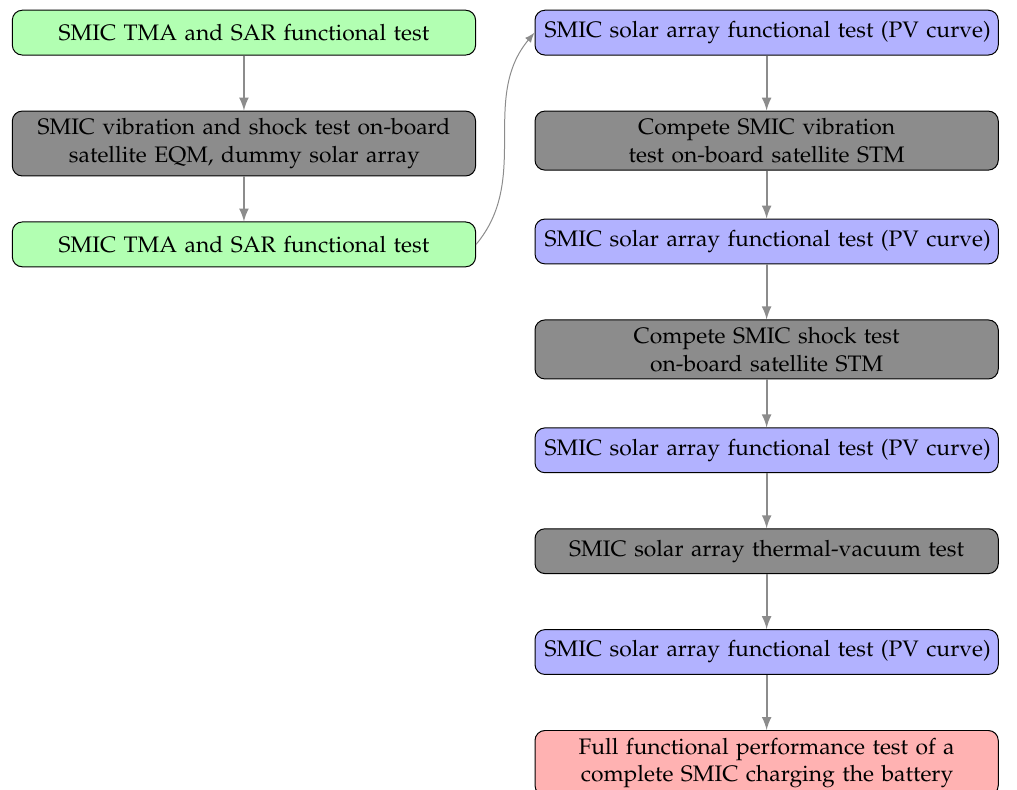
Figure 4. The sequence of qualification tests proposed to the SMIC. In the sequence of the tests on the left, solar arrays are not included in the tests to reduce the risk of damaging the expensive solar cells. Only the TMA and SAR units of the SMIC are tested there, shown in green. Solar arrays are tested in the sequence on the right, with PV curves obtained at the purple steps in the process. The complete SMIC was functionally tested with the battery at the end of the qualification process, shown in